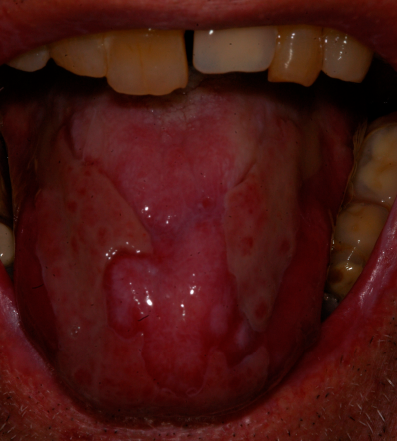
Figure 2. Clinical view of the patient after one year of conventional therapies.